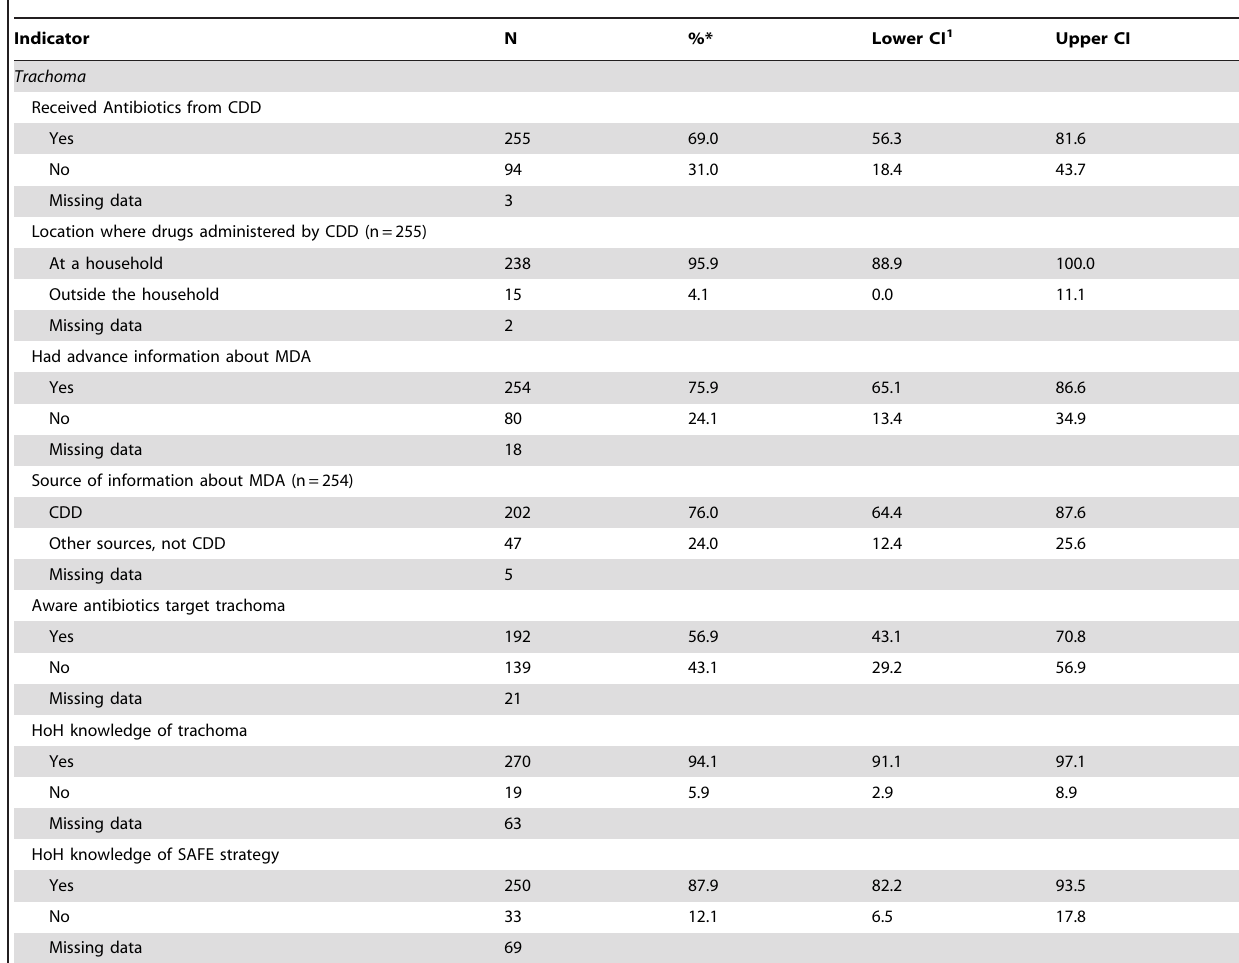
Table 1. Head of Household Responses (n=352 unless